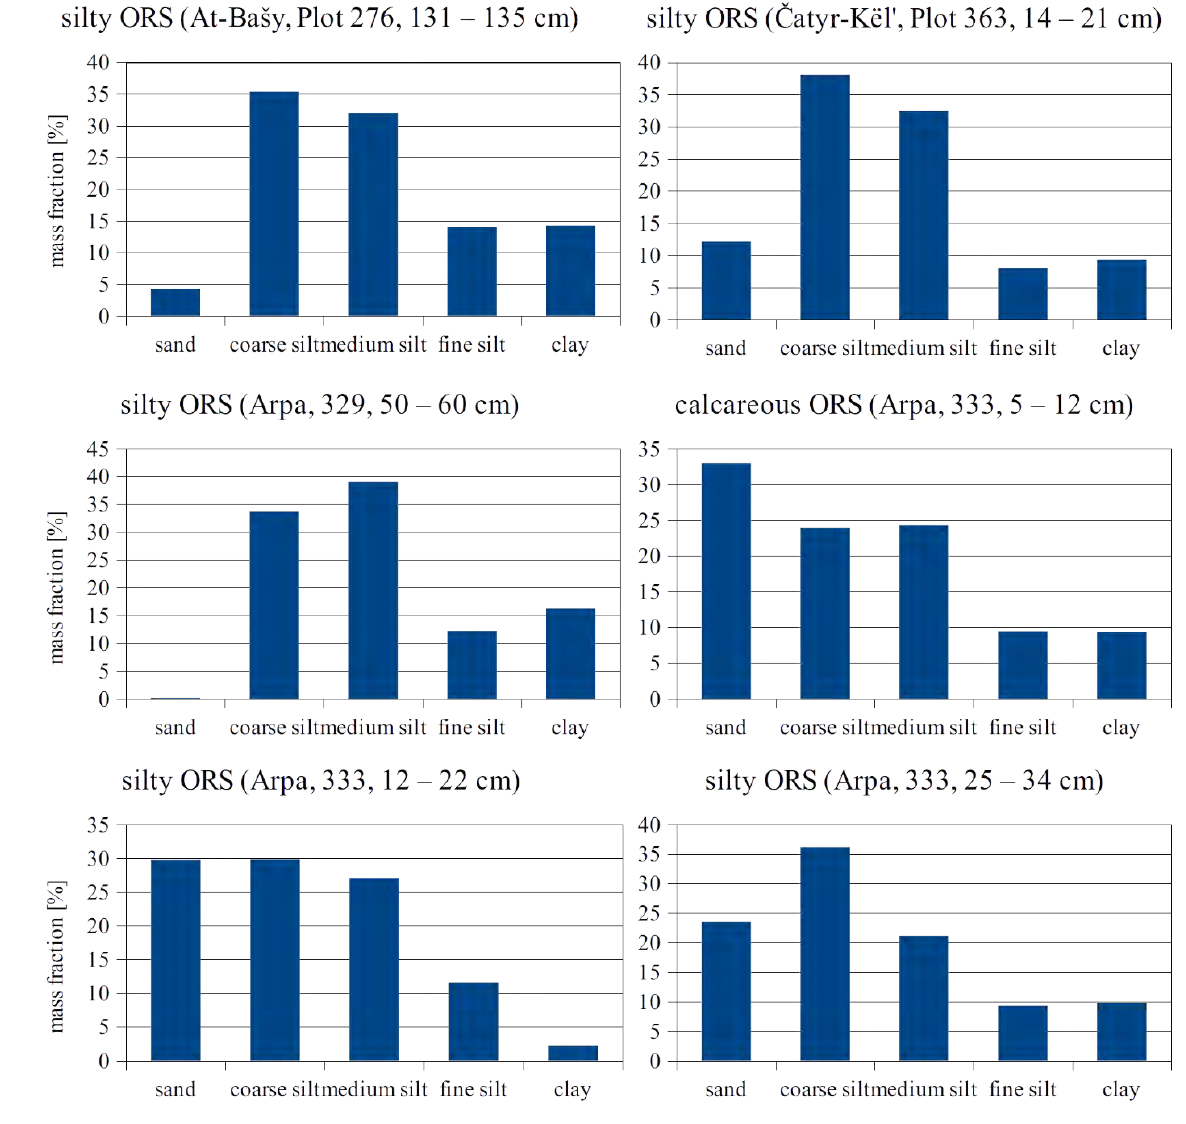
Figure 7. Histograms showing relative proportions of particle size classes of ORSs of all peatlands. In brackets: peatland, plot number and depth of substrate layer. (For overview samples of all peatlands are